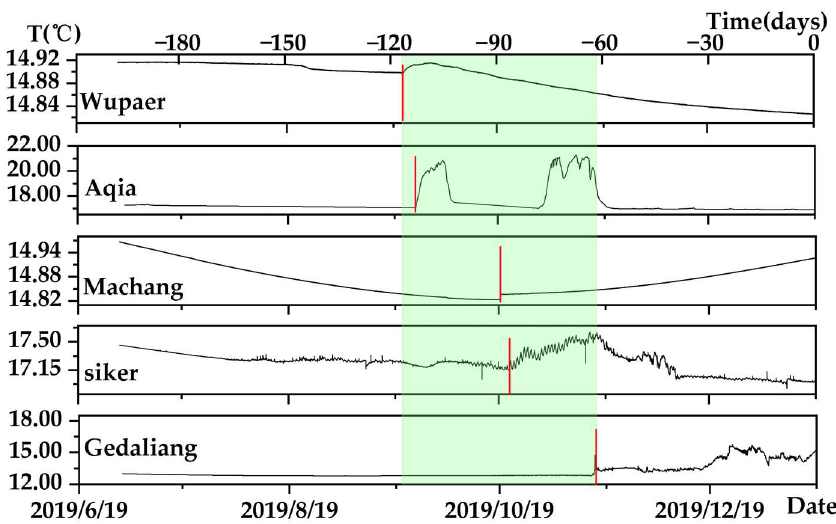
Figure 4. Short-term abnormal changes in bedrock temperature at different observation stations. The red vertical lines indicate an abnormal start time. The green area is an abnormal change in shape. 0 denotes the time of earthquake occurrence.